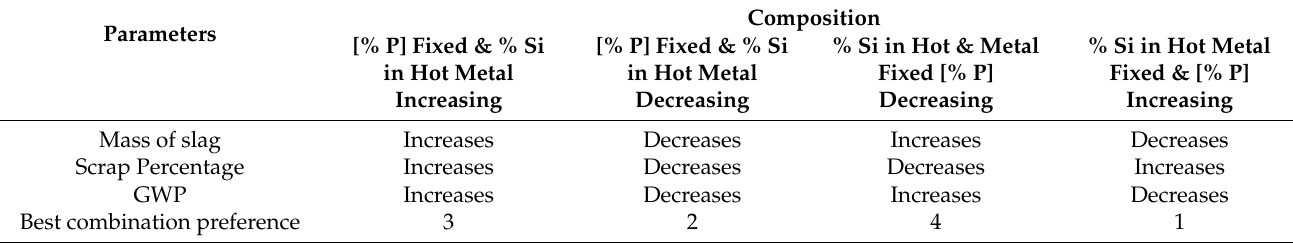
Table 3. Effect of different combinations on mass of slag, scrap percentage, and global warming.